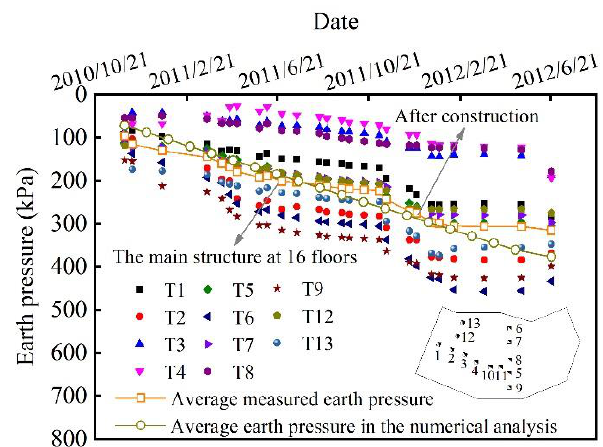
Figure 18. Curve of earth pressure variation with time .